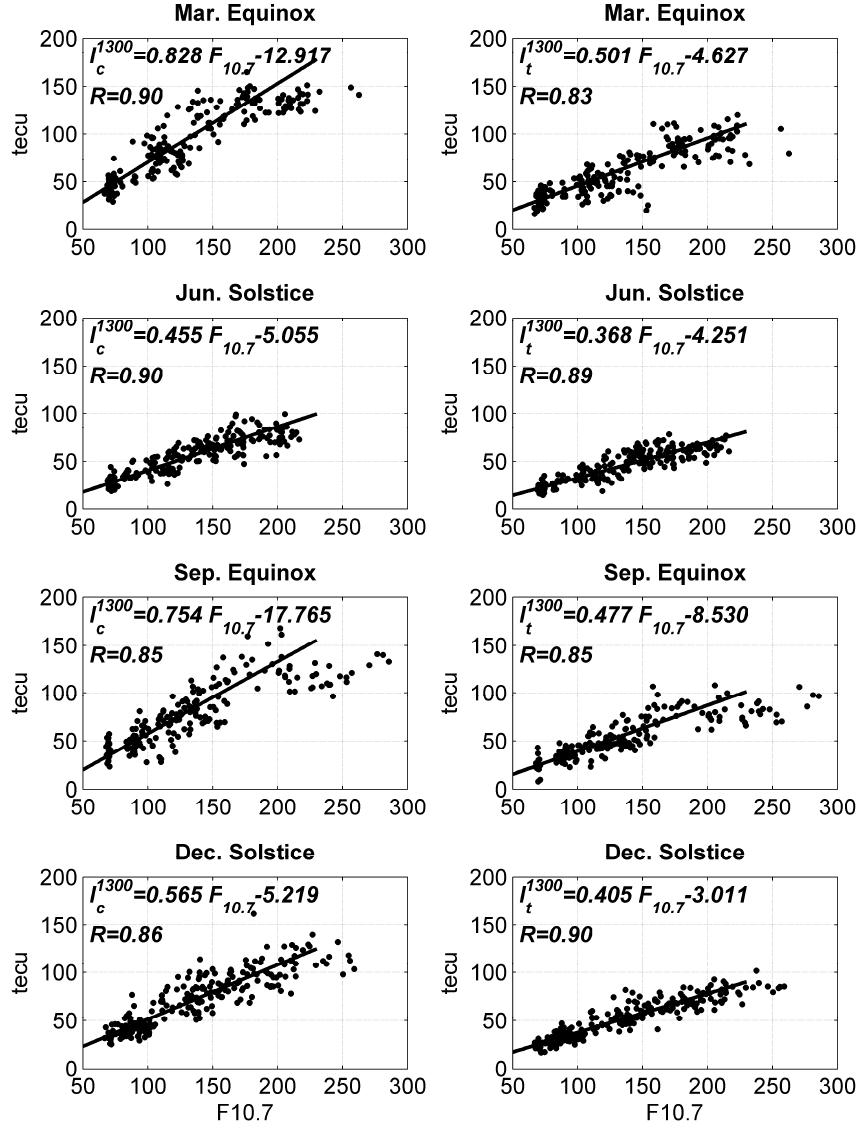
Figure 6a. Panels from top to bottom show F 10.7 , equivalent crest value per solar flux unit, Fig. 6a. Solar activity (F10.7) dependence of noontime (13:00LT) TEC in different seasons for two latitude regions for the (left) EIA crest, (right) EIA and trough value per solar flux unit and CTR at 1300 LT. Solid lines show the variation of the corresponding monthly mean values.